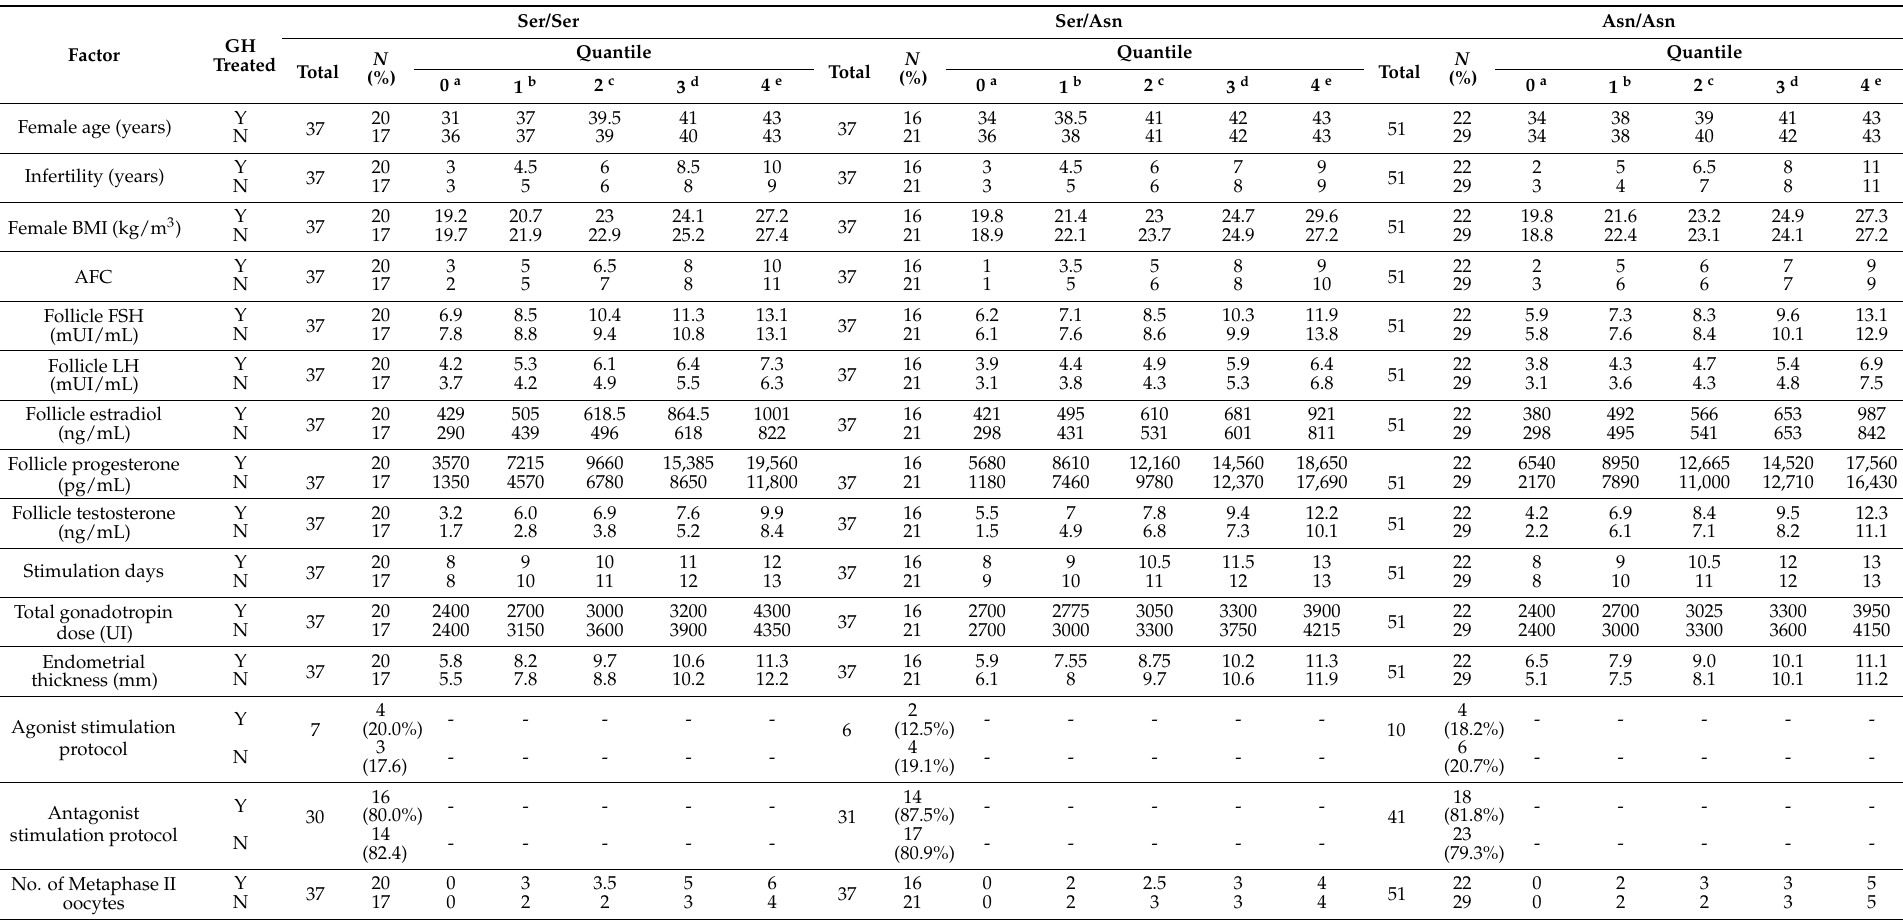
Table 1. Distribution of demographic, clinical and paraclinical factors among study participants who received GH treatment ( n = 58), and those who did not receive GH treatment ( n =